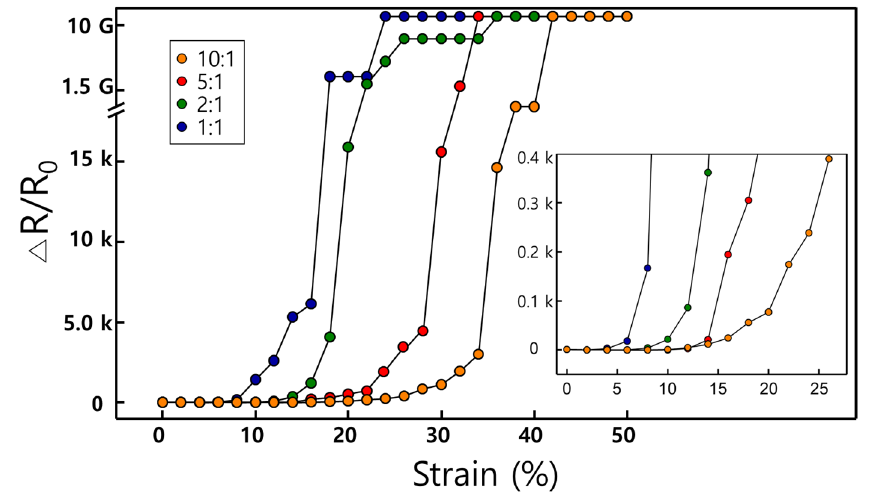
Figure 5. The graph shows the relative resistance ( Δ R/R 0 ) with the maximum tensile strain